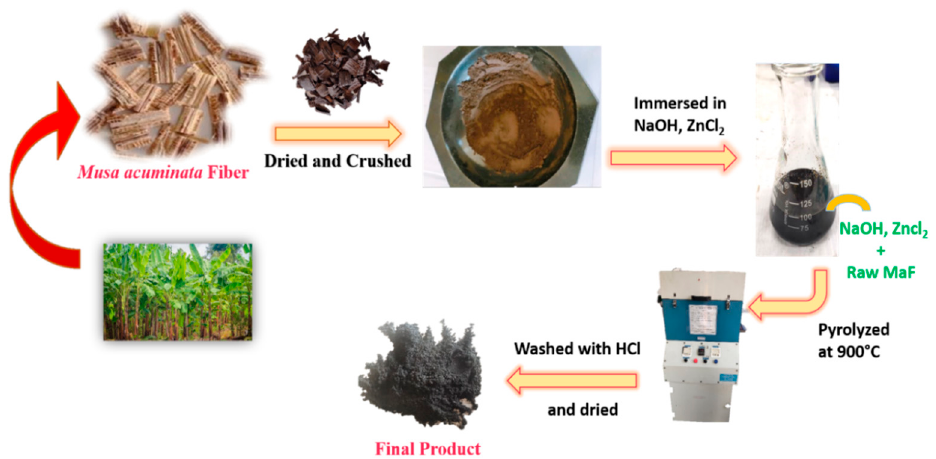
Figure 1. Synthesis processes of MaFDHC powders.